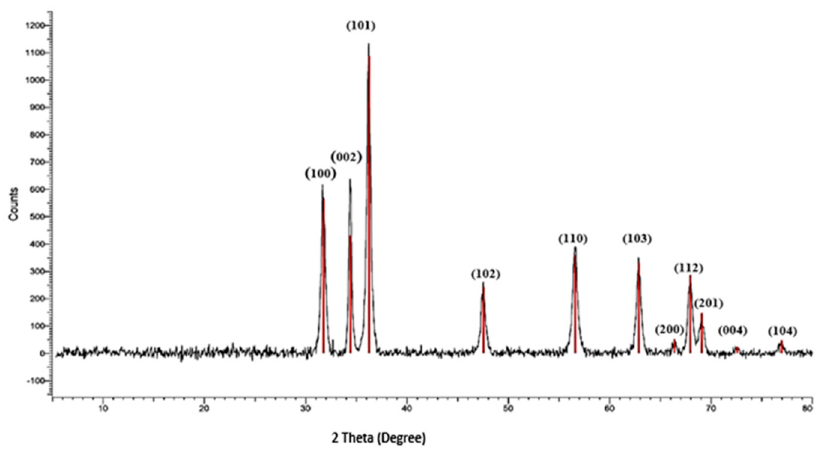
Figure 1. UV–visible spectra of synthesized ZnO NPs.